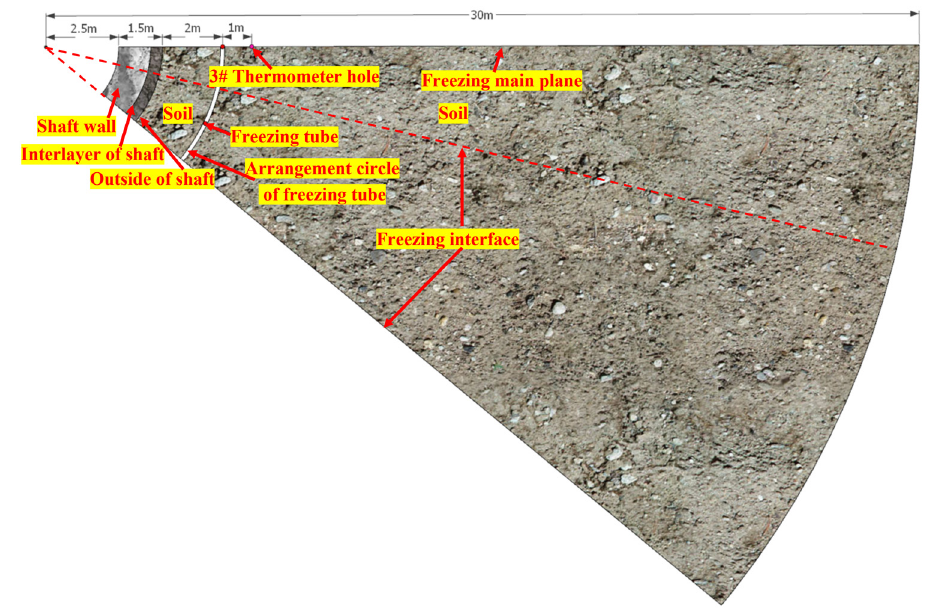
Figure 5. Geometric model.